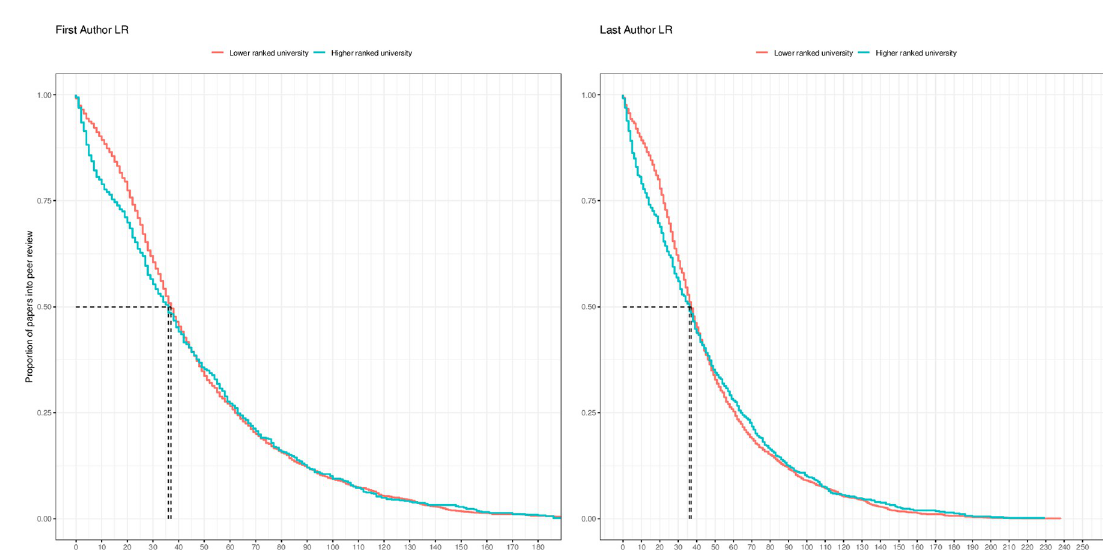
Fig 2. Survival plots of time from submission to publication for COVID-19 papers authored at higher-ranked (teal line) versus lower ranked universities (red line). The groups of highly ranked and lower ranked universities are inferred from the Leiden Ranking. Dashed black lines specify the difference in median review times of papers from highly ranked and lower ranked